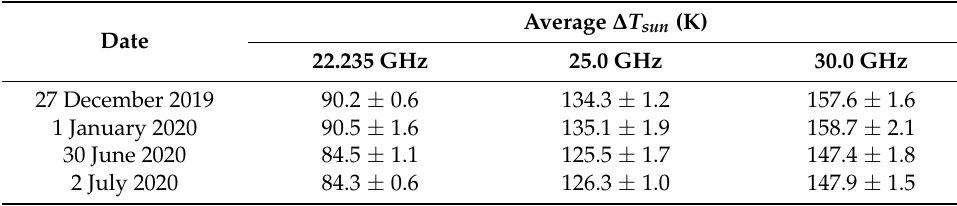
Figure 8. The variation of the T B increment as a function of time before the solar eclipse on 26 December 2019 and 21 June 2020 (red curve) as compared with that after the solar eclipse on 27 December 2019 and 30 June 2020 (blue curve). ( a ) 22.235 GHz, ( b ) 25.0 GHz, ( c ) 30.0 GHz. Table 5. Average T B increment during non-eclipse conditions.